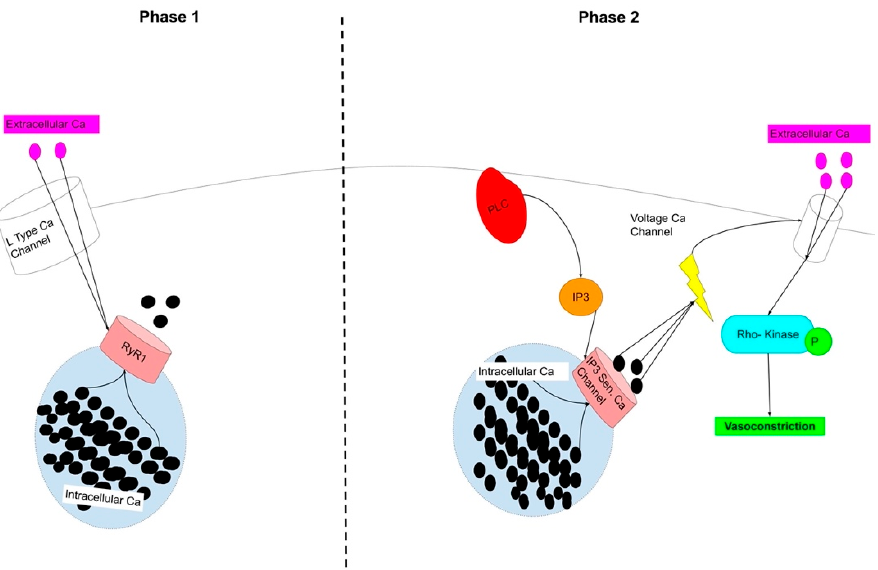
Figure 4. The proposed mechanism for the two-stage, calcium-induced vasocontraction consists of first increased calcium from the sarcoplasmic reticulum via the ryanodine receptor (RyR1). This is followed by an IP3-dependent increase in calcium from intracellular stores which leads to a voltage change and additional rise in intracellular calcium leading to Rho-kinase activation and